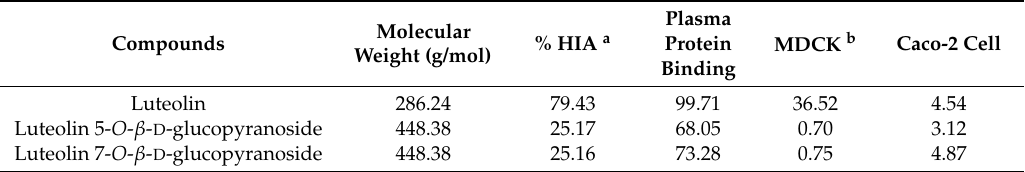
Table 6. Absorption, distribution, metabolism, and excretion (ADME) properties of luteolin and its derivatives from C. maackii .